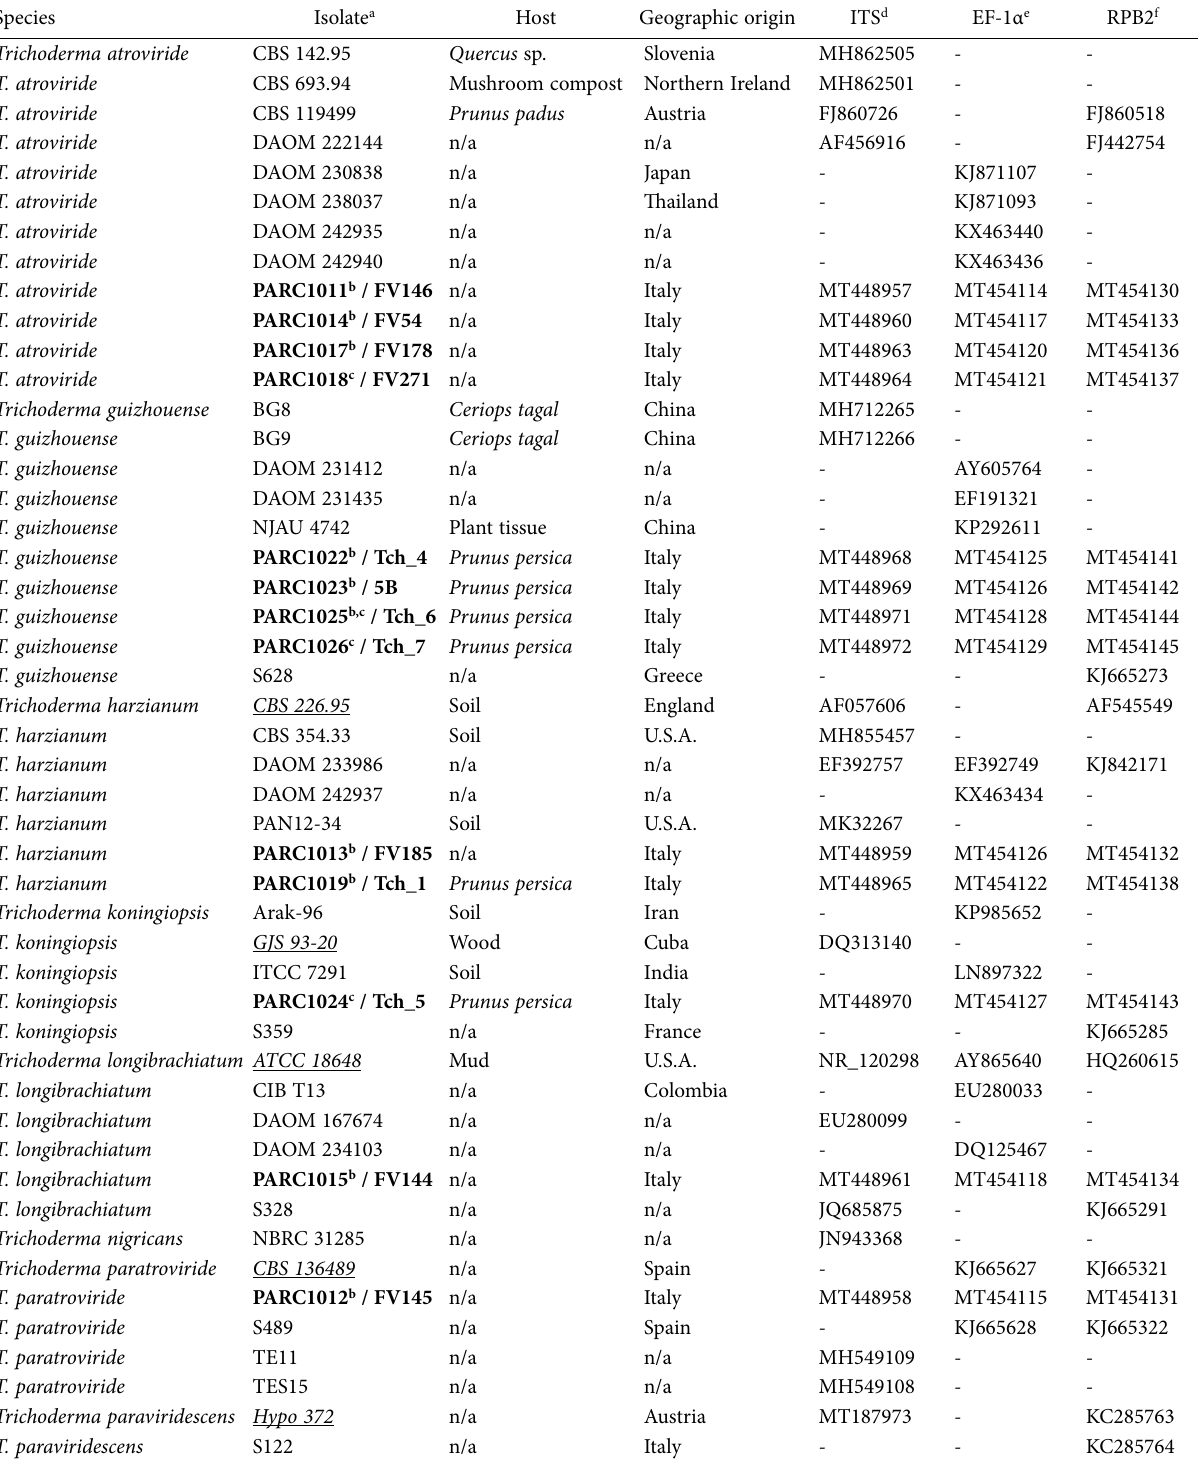
Table 1. Trichoderma isolates used in this study and their GenBank accession numbers.